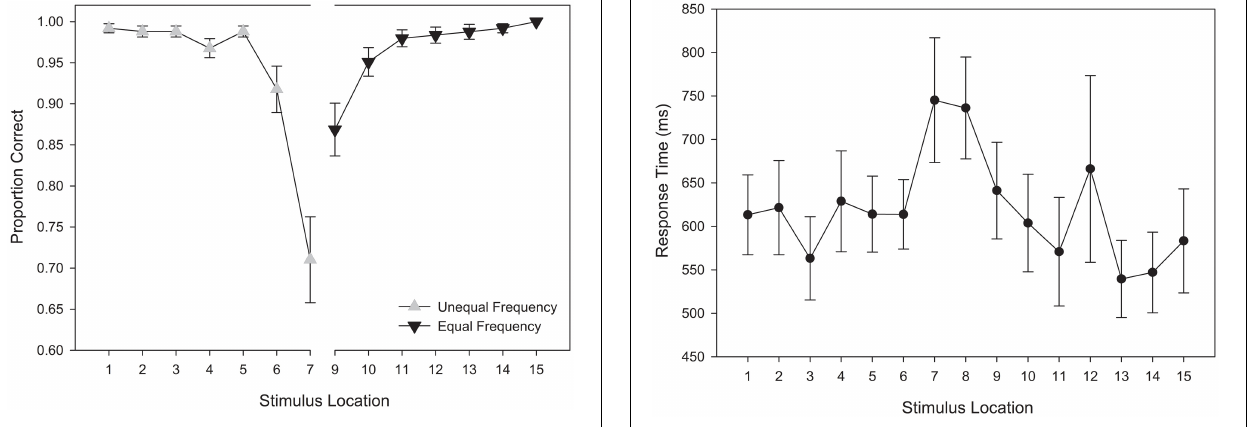
= 0 . 134 4 . An examination of Figure 12 indicates p = 0 . 036, η 2 p